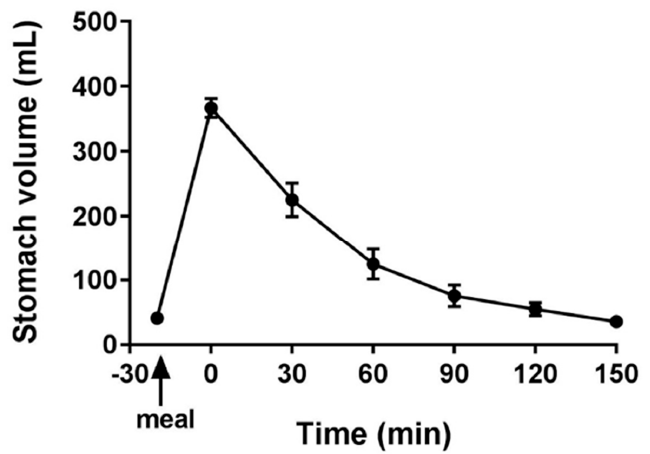
Figure 2. Gastric volumes measured with MRI plotted against time before and after feeding the soup test meal. n = 12 participants, data are shown as mean ± SEM.